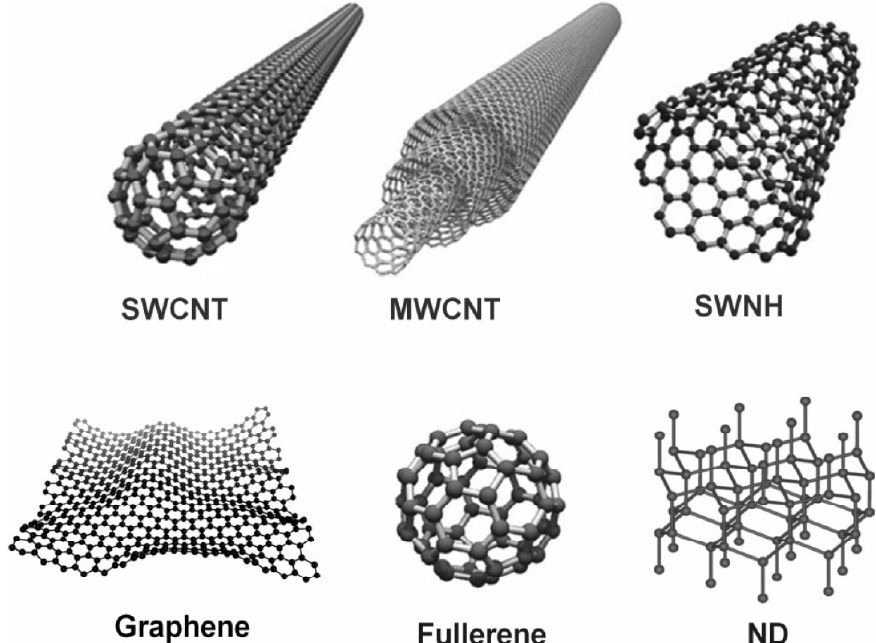
Fig. 4. Schematic representation of different CNMs. Reprinted with permission from G. Modugno, C. M. Moyon, M. P. D. Boldor // British Journal of Pharmacolo 172 (2015) 975. Copyright 2014 The British Phar- macological